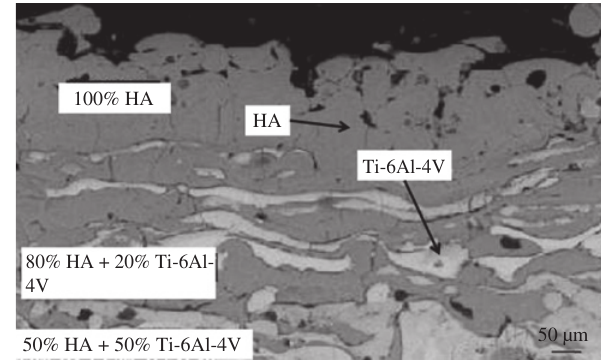
Figure 27: Functionally graded HA/Ti-6Al-4V coating